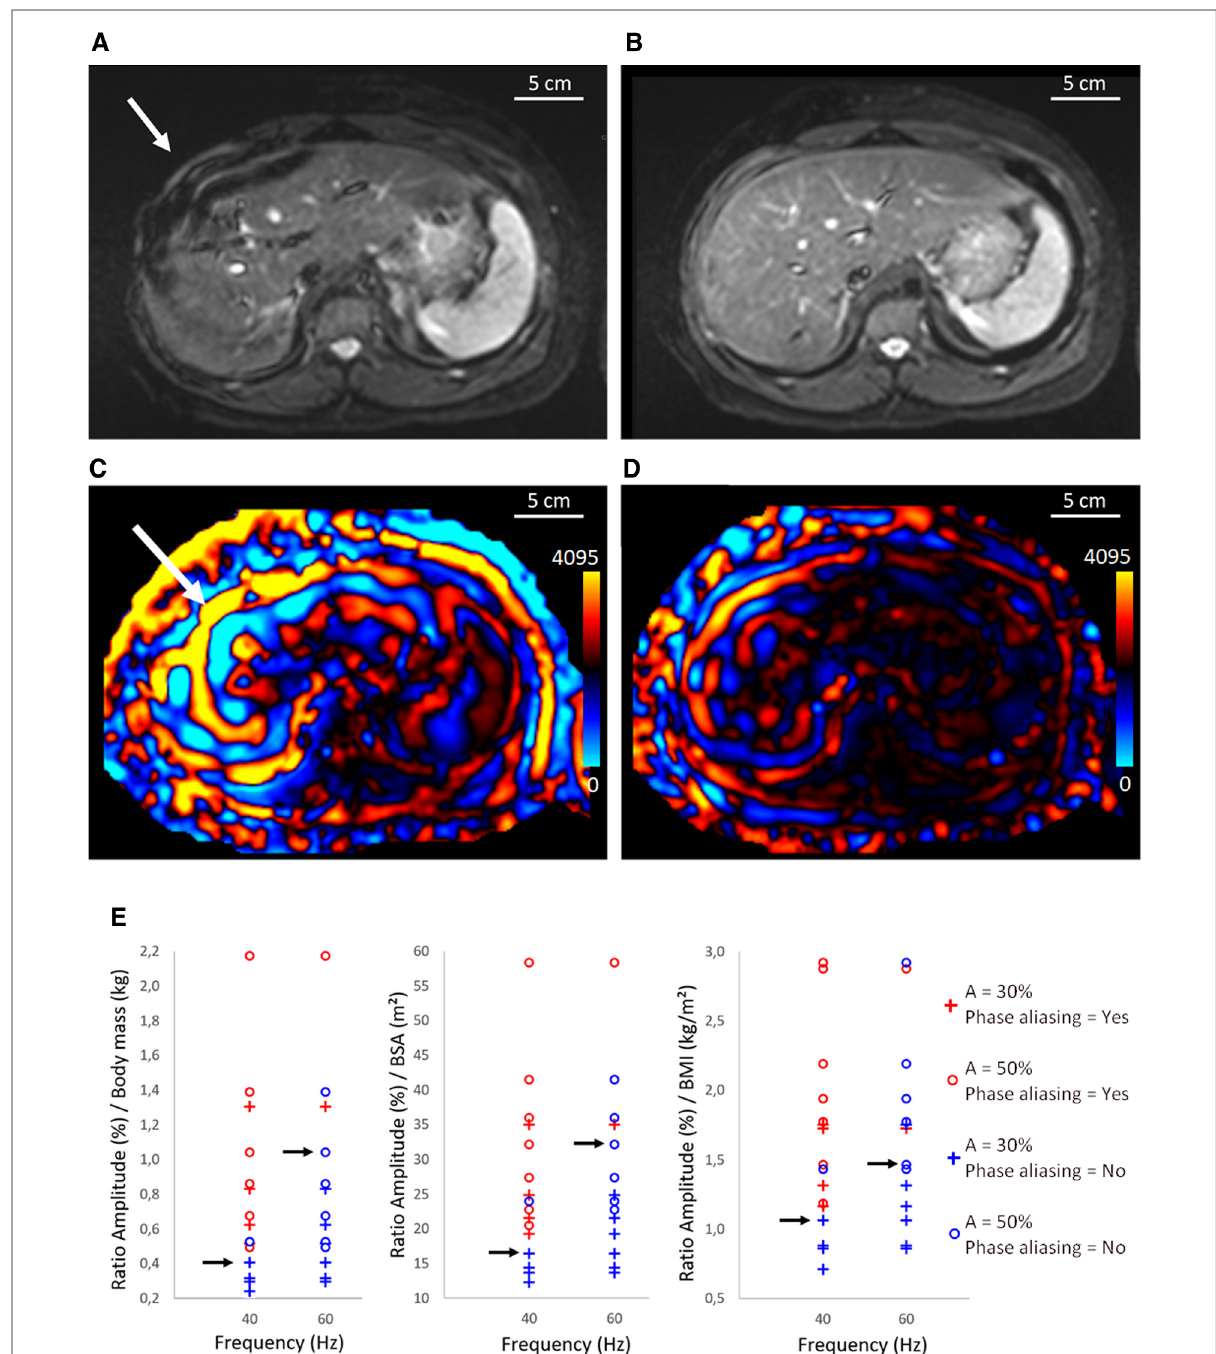
FIGURE 2 Illustration of magnitude images acquired the TSE MRE sequence ( A , B ) and corresponding shear wave ( C , D ) for case with phase aliasing at 40 Hz ( A , C ) and case without phase aliasing at 60 Hz ( B , D ). The white arrow shows signal void artifacts caused by overstated amplitude of the vibrational excitation. ( D ) corresponds to a threshold amplitude. ( E ) Determination of the threshold amplitude using the BM, BMI, and BSA as a function of the elastographic frequency. Red color corresponds to phase aliased cases and blue color corresponds to nonaliased ones using 30% and 50% of the output amplitude. The black arrows indicate the highest ratio before phase aliasing for 40 and 60 Hz. One patient had morbid obesity, and the amplitudes of 30% and 50% were too low to perform a reliable MR elastography at 60 Hz. MRE, magnetic resonance elastography; BM, body mass; BMI, body mass index; BSA, body surface area; A, Amplitude; TSE, turbo spin